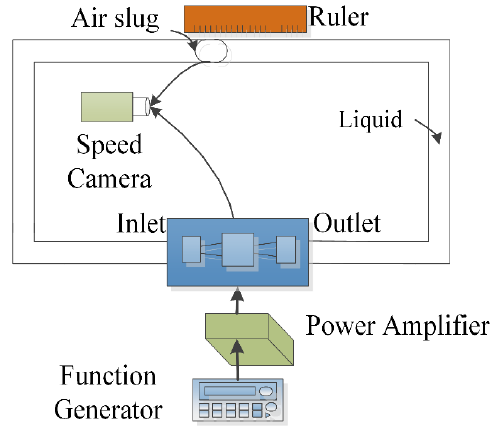
Figure 3. Schematic of experimental apparatus.